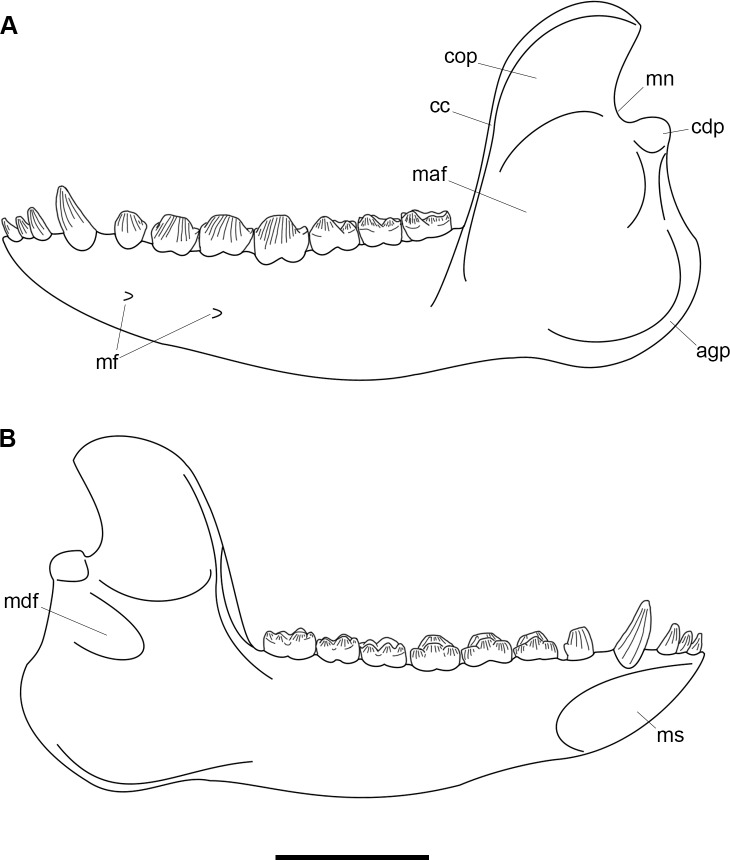
Annotated line drawing of the left dentary of Periptychus carinidens.(A) lateral view; (B) medial view. Abbreviations: agp, angular process; cc, coronoid crest; cdp, condyloid process; cop, coronoid process; maf, masseteric fossa; mdf, mandibular foramen; mf, mandibular foramina; mn, mandibular notch; ms, mandibular symphysis. Scale bar: 30mm.